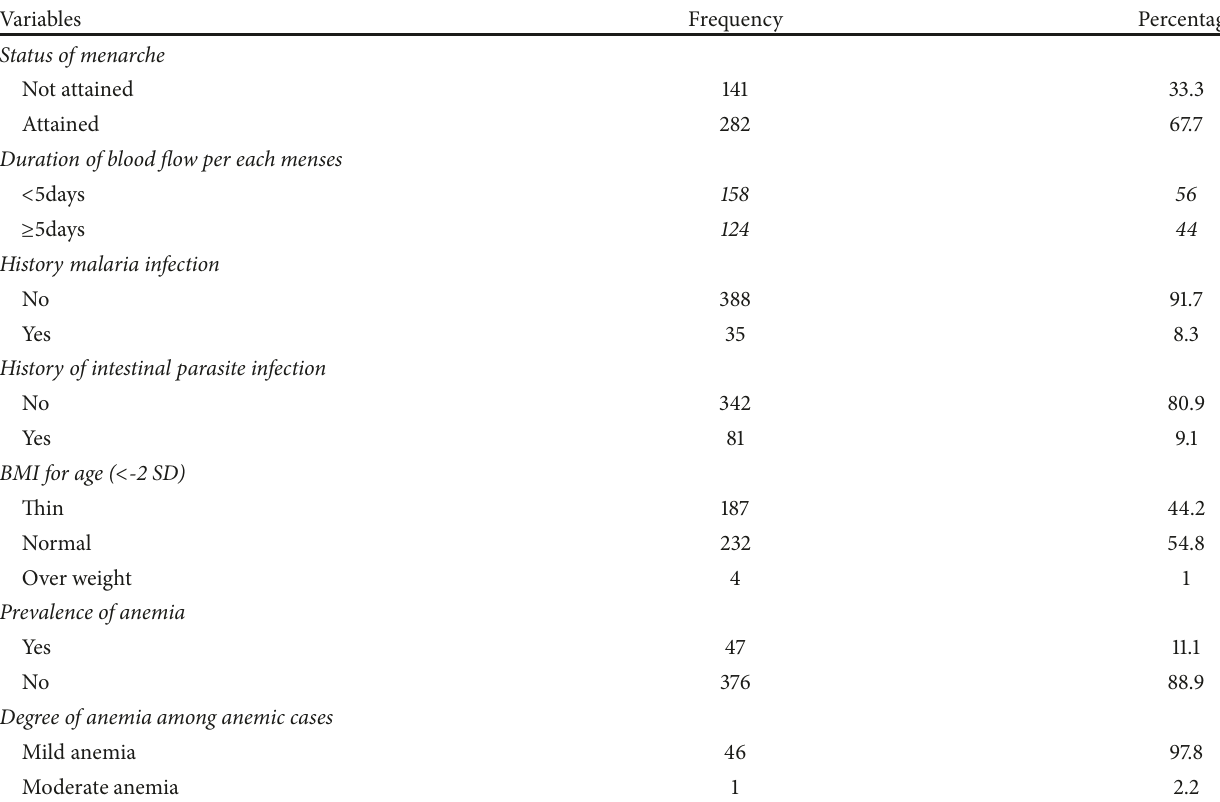
Table 4: Anemia, health, and nutritional status of school adolescent girls at rural towns of Bahir Dar city administration, 2017 (n=423).